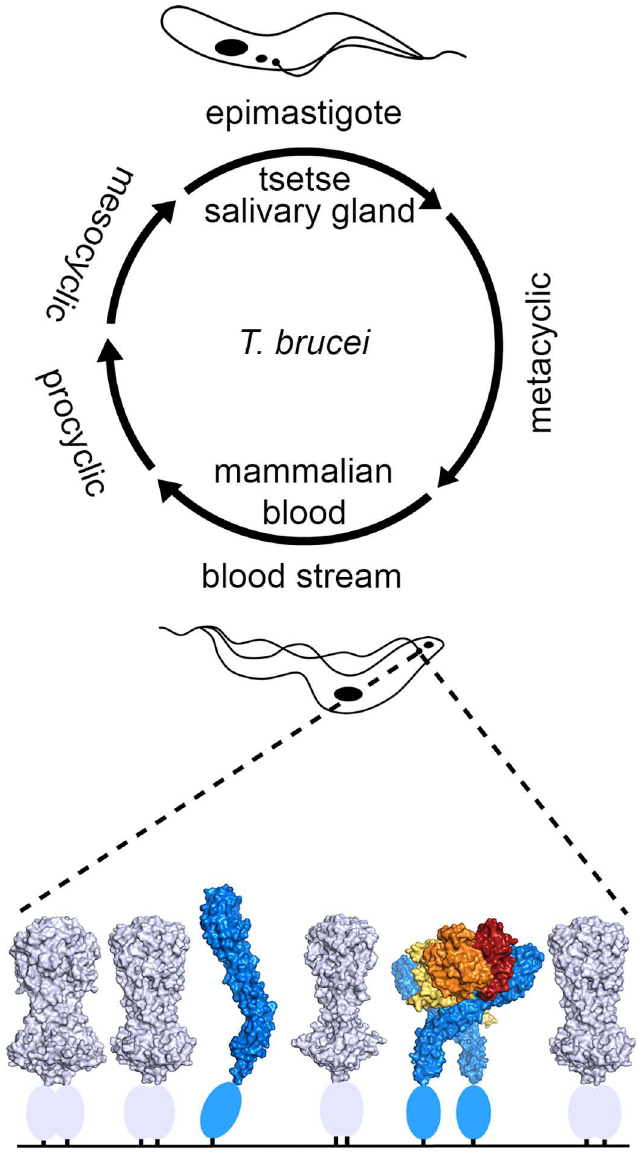
Fig 3. The T. brucei HpHbR is a bloodstream form HpHb receptor. In the life cycle of T . brucei ,the epimastigotes inhabit the salivary glands of the tsetse fly and do not express HpHbR. Instead, TbHpHbRis predominantly expressedin the bloodstream form, in which it acts as an HpHb receptorthat exists within the denselypacked VSG layer. In the structure figure HpHbRis blue, VSG is blue-white, and HpHb is yellow, orange, and red. The ovals represent the C-terminal domainsof the VSG and HpHbR. These lie betweenthe N-terminal domainsand the membrane, but their relative locationsare